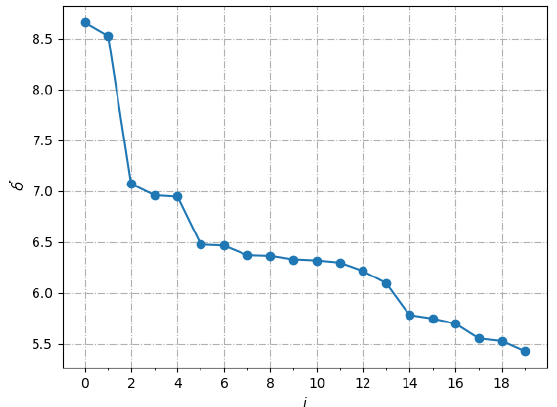
Figure 4. The first 20 singular values of the trajectory matrix X1.